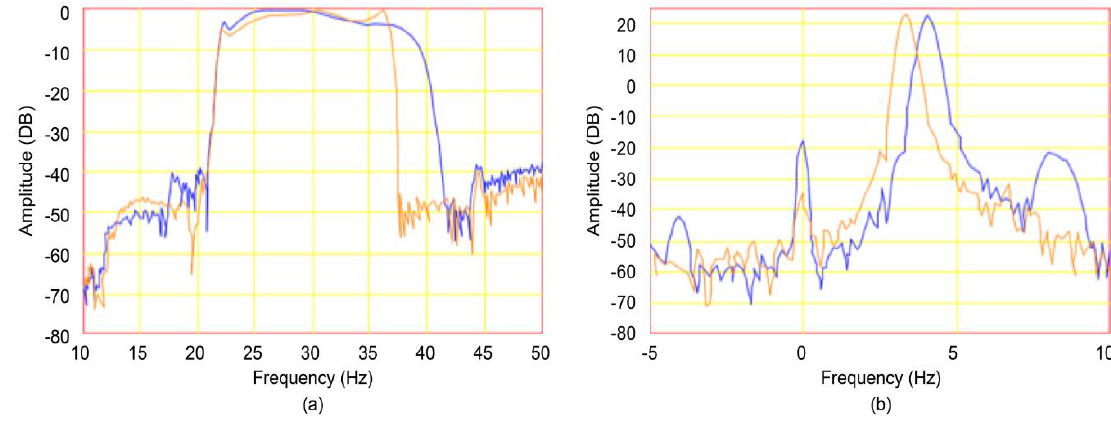
Figure 4. Spectrum of the phase current signal of a motor. ( a ) Fast Fourier Transform (FFT); ( b ) Demodulation. The red line indicates health status, while the blue line indicates failure, as shown in [40]. Reproduced with permission from IEEE,